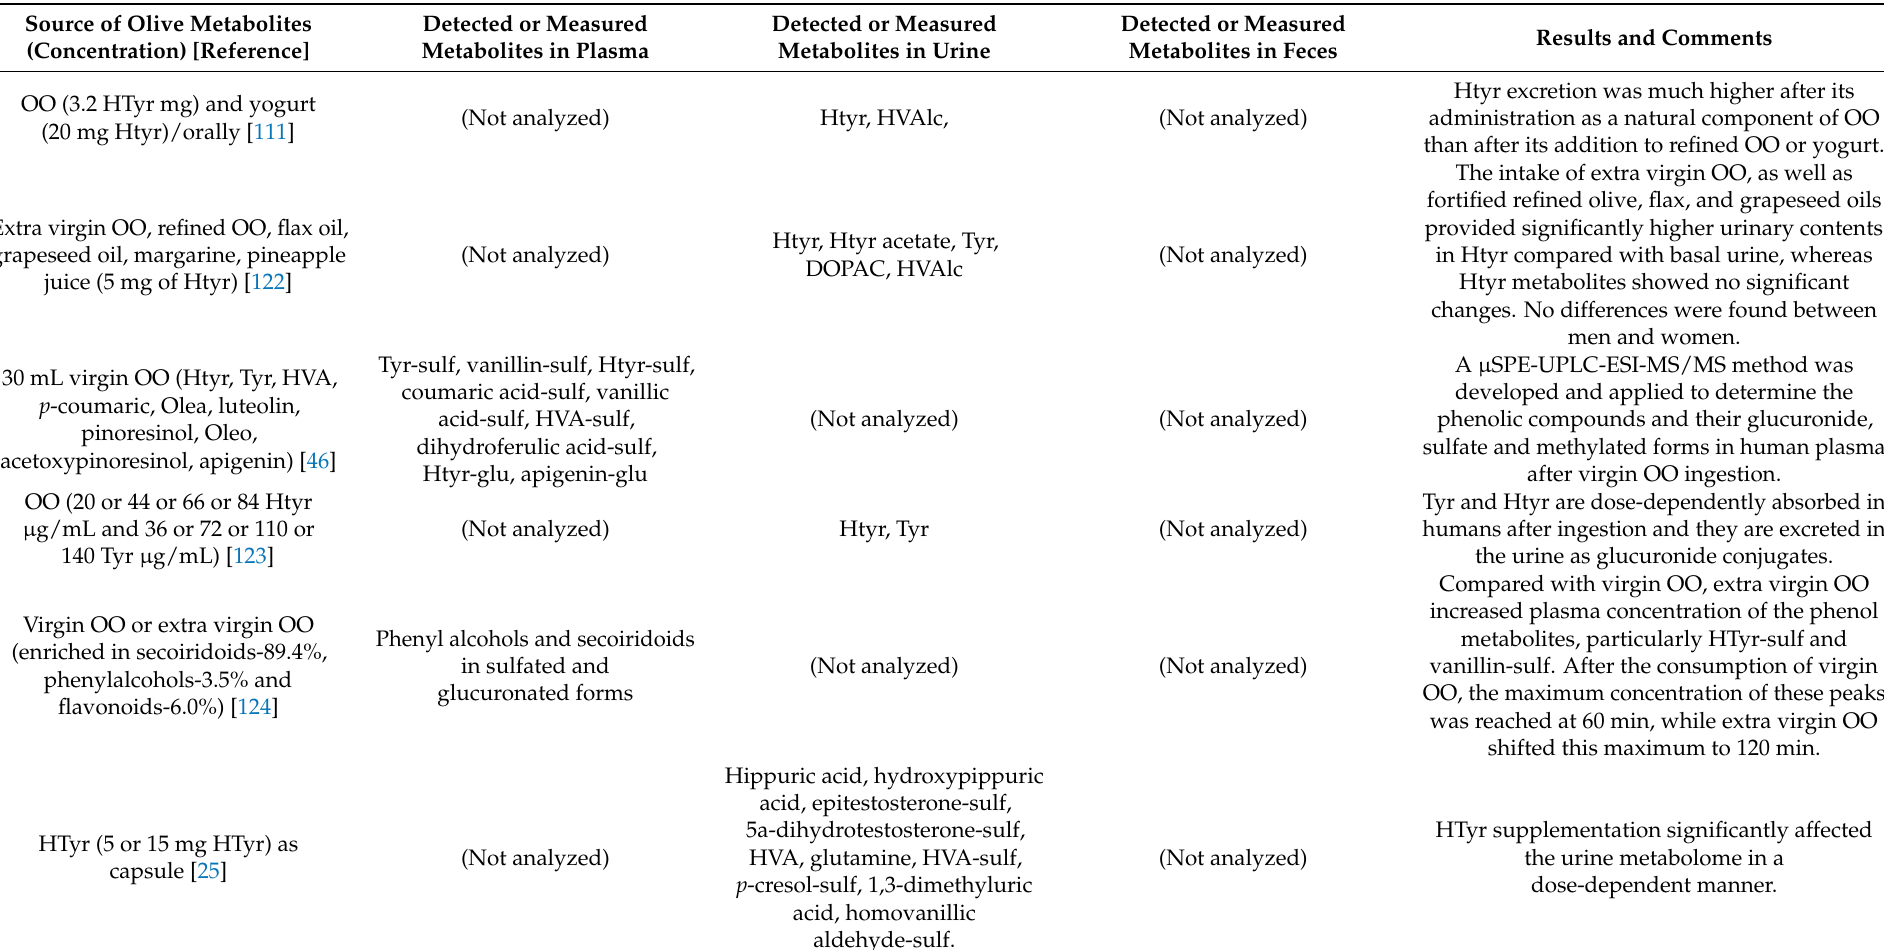
Table 2. Published literature on metabolism of olive bioactive constituents through human